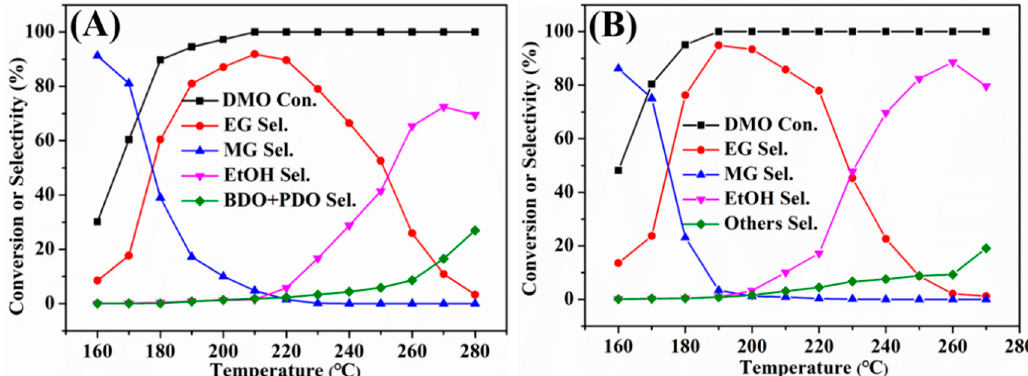
Figure 6. The correlation relationship between catalytic activity and reaction temperature of ( A ) Cu/SiO 2 and ( B ) 2B- Cu/SiO 2 catalysts.